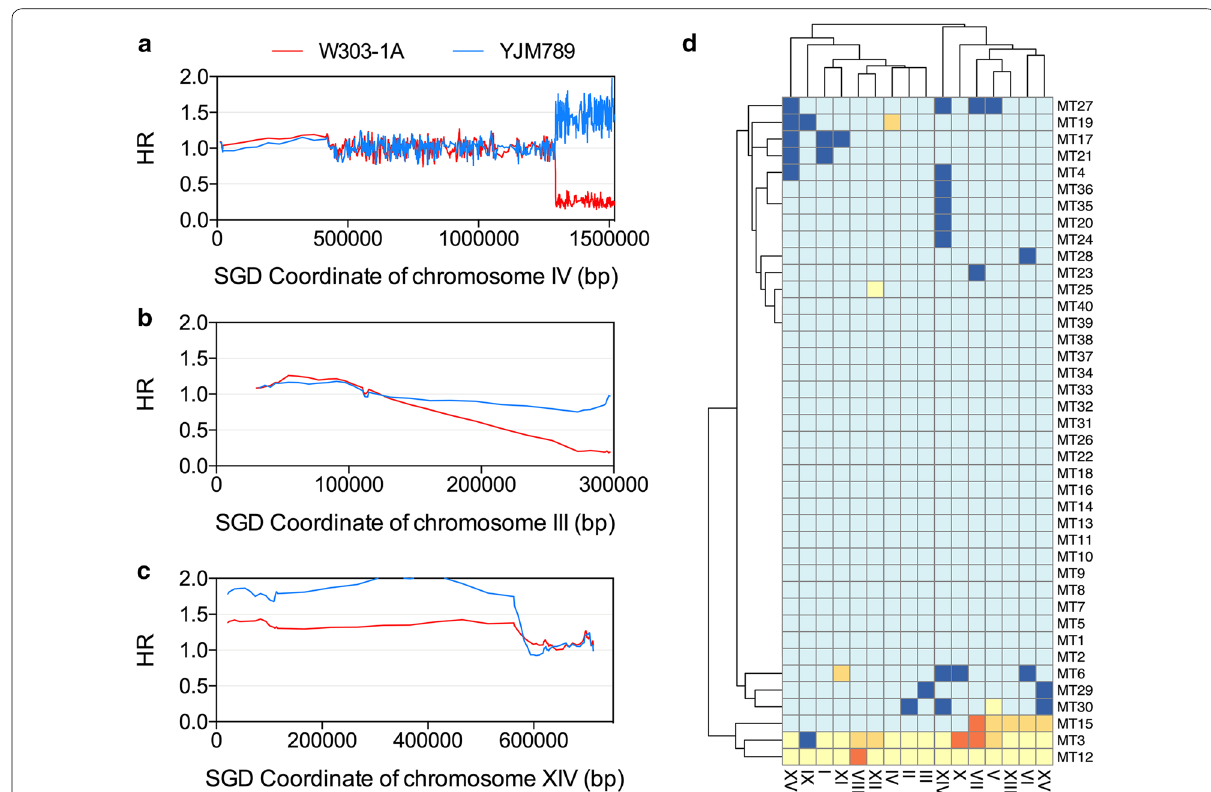
Fig. 5 Chromosomal instability resulting from carbendazim treatment in JSC25‑1. Genomic alterations were detected in 40 carbendazim‑treated isolates (MT1–MT40) by the chr IV–specific SNP microarray. a An example of a carbendazim‑induced terminal LOH event on the right arm of chr